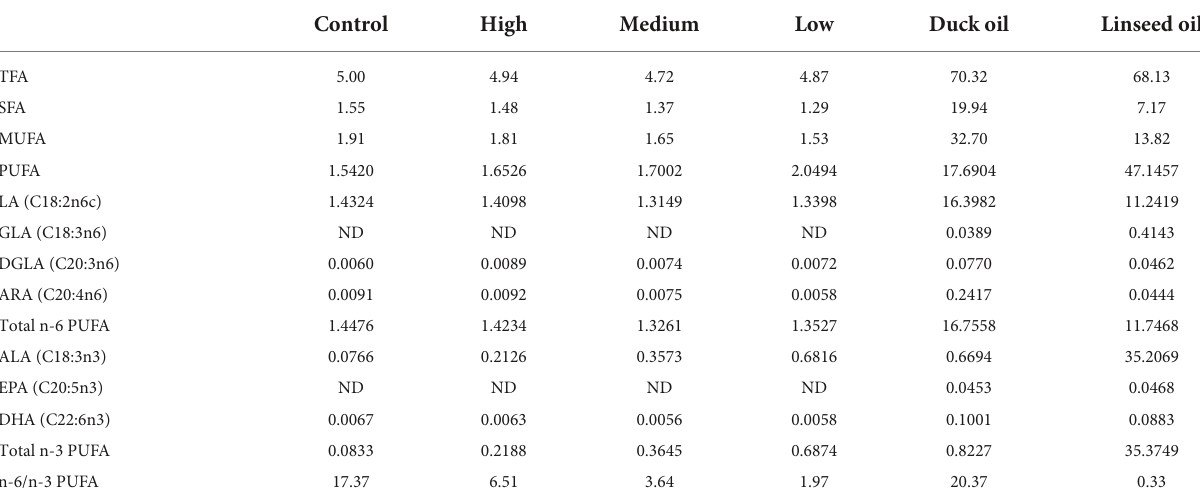
TABLE 2 Fatty acid (FA) composition of diets. Fatty acids